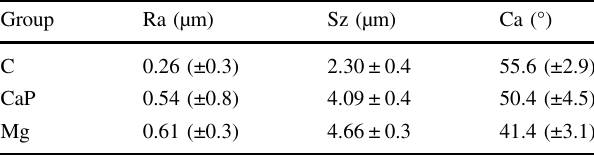
Table 2 Linear surface roughness (Ra), area roughness (Rz), wettability (CA) of the study